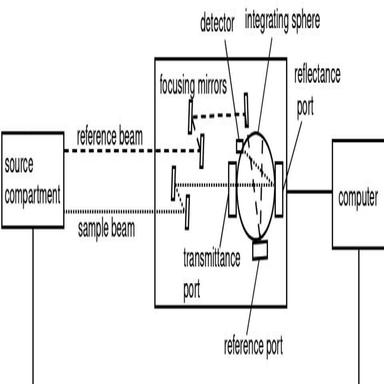
Schematic of experimental setup for measuring directional–hemispherical reflectance and transmittance .